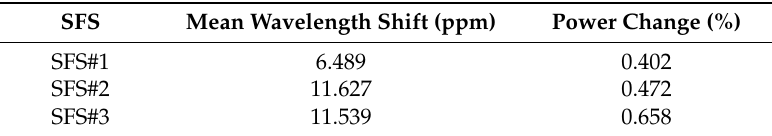
Table 2. Stabilities of SFSs for 25 h at Room Temperature.